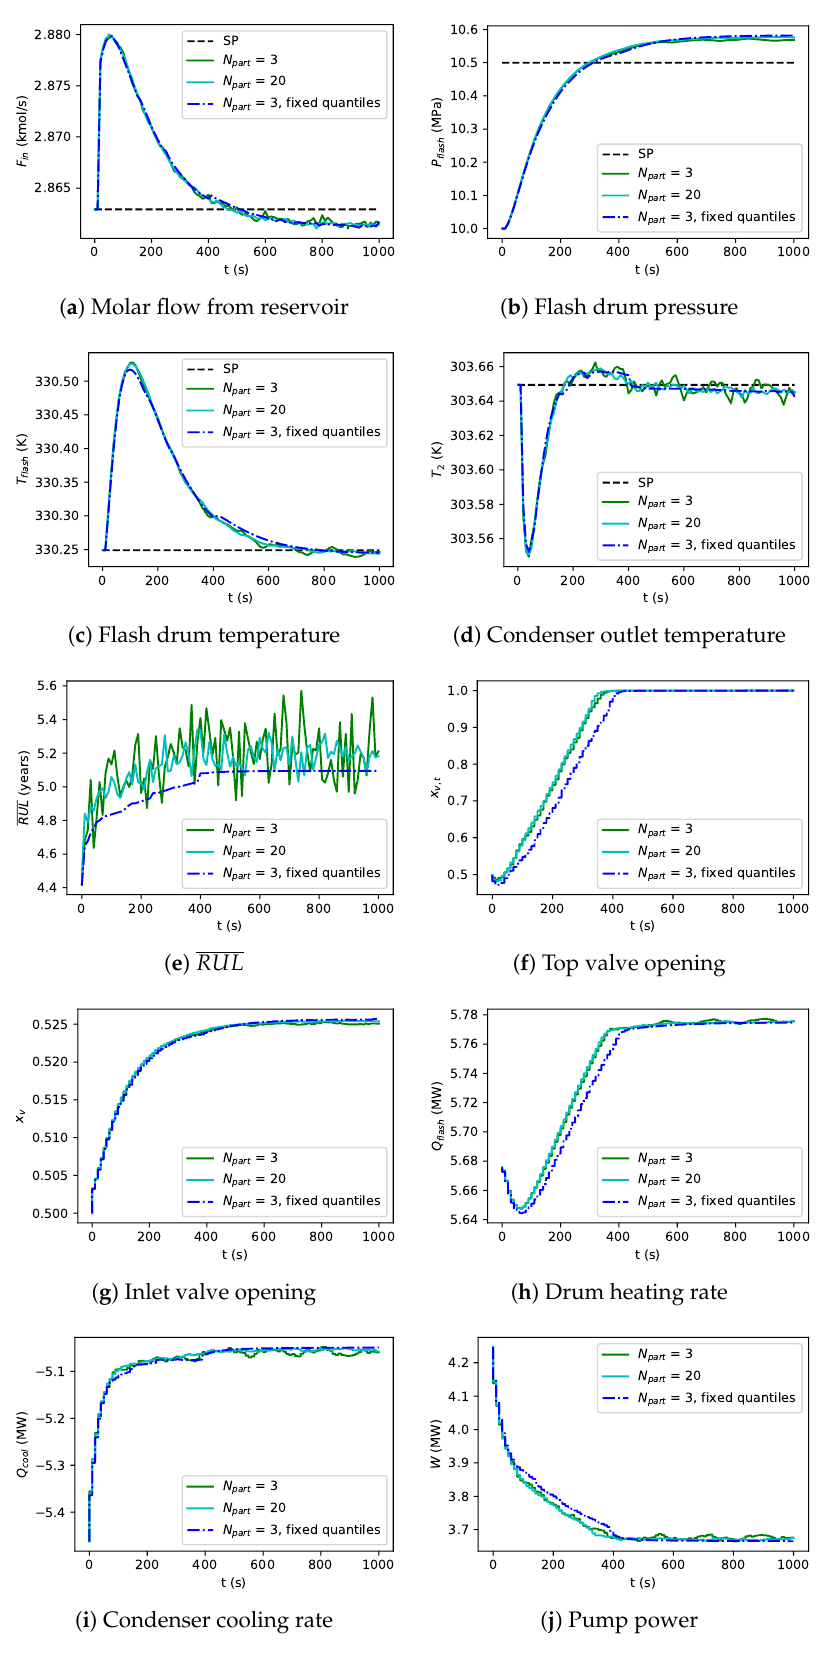
Figure 12. HAC simulations—evaluation of sampling noise ( w HAC =